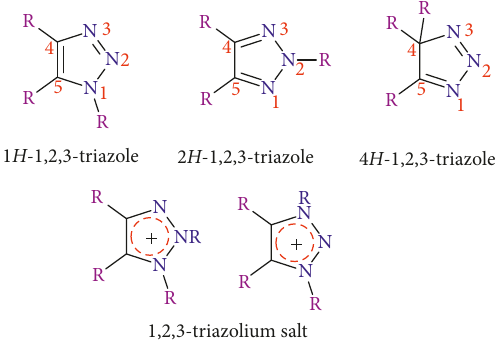
Scheme 1: The two main classes of 1,2,3-triazoles.